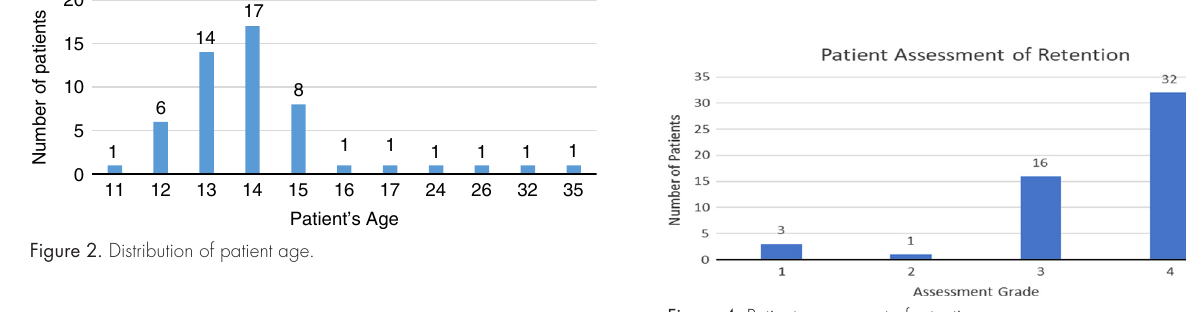
Figure 4. Patient assessment of retention.